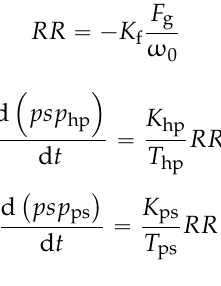
Figure 6. “Power system” block ( T sc (s) is the parameter of the transfer function used to model